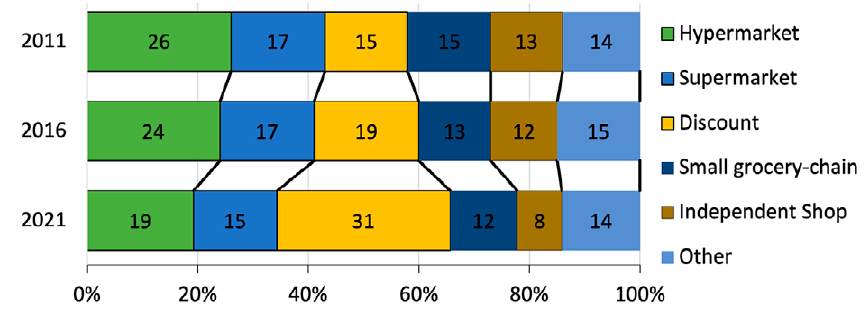
Figure 1. Distribution of sales channels in Hungary, 2011-2021 Source: self-made, based on GfK Hungária (household panel)